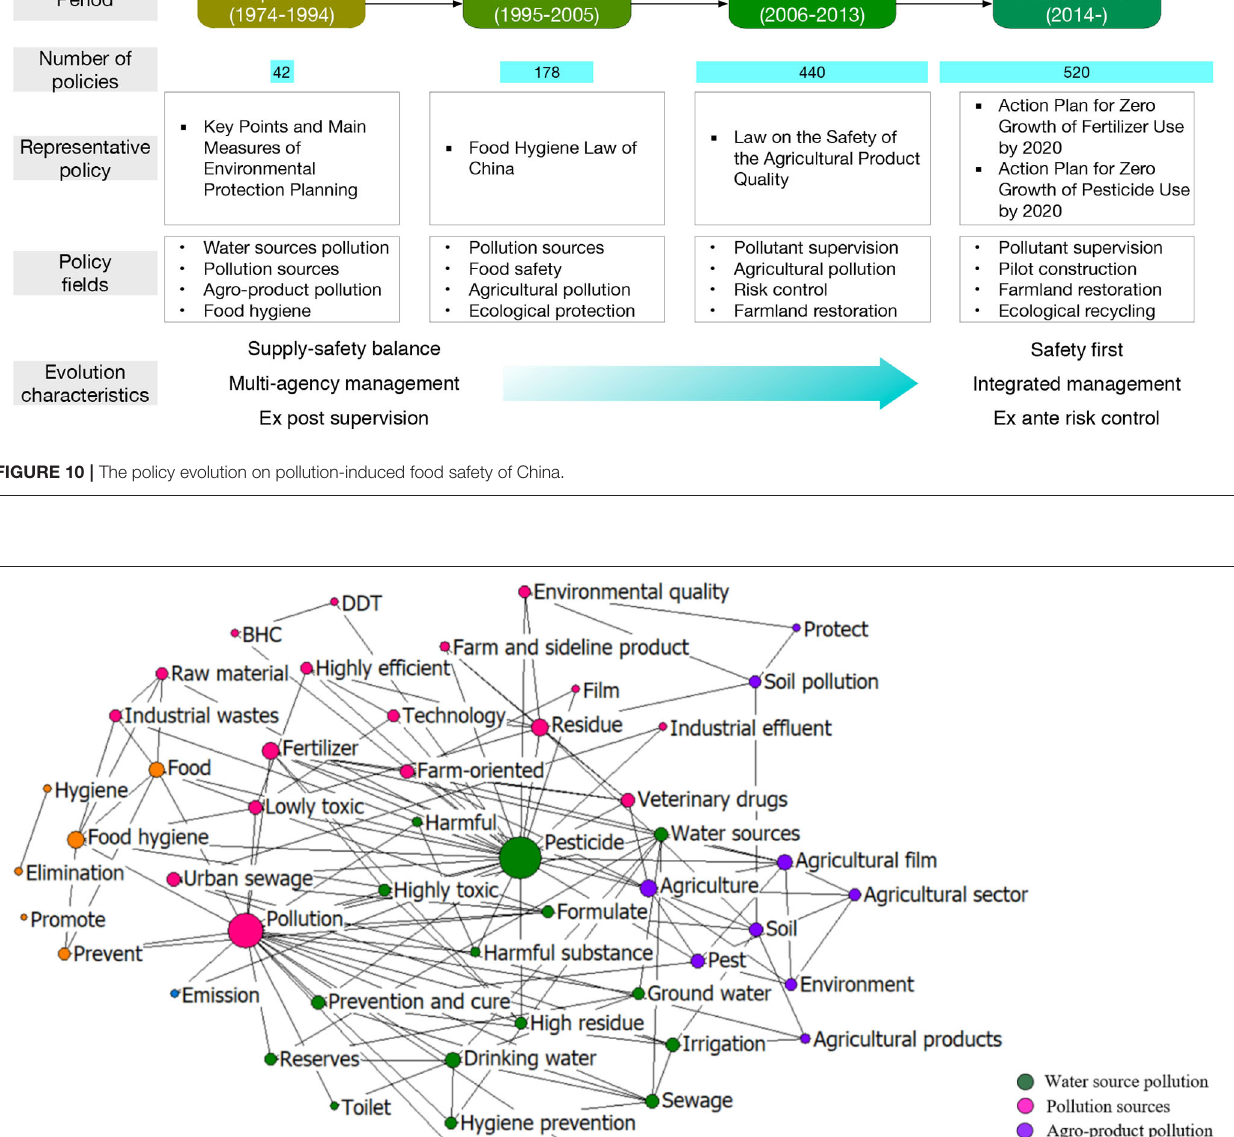
Management of Pesticides and Veterinary Drugs” in 1992.